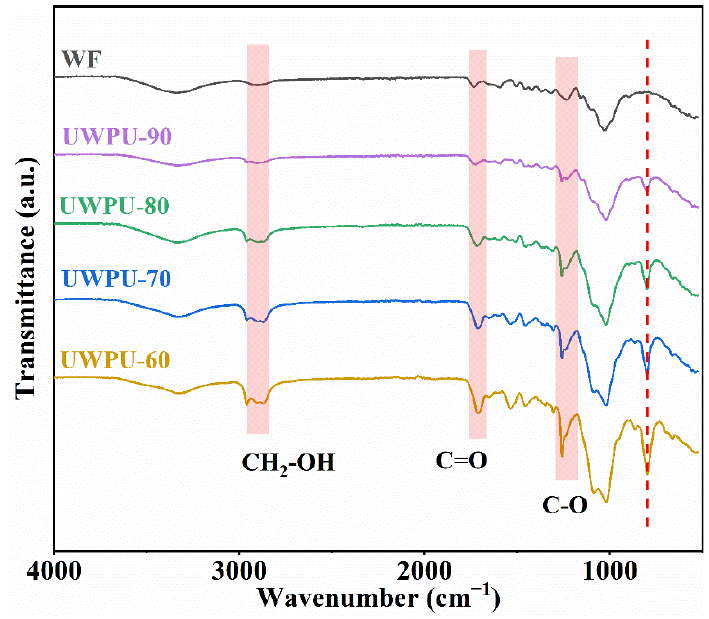
Figure 2. FT-IR spectra of UWPU composites.